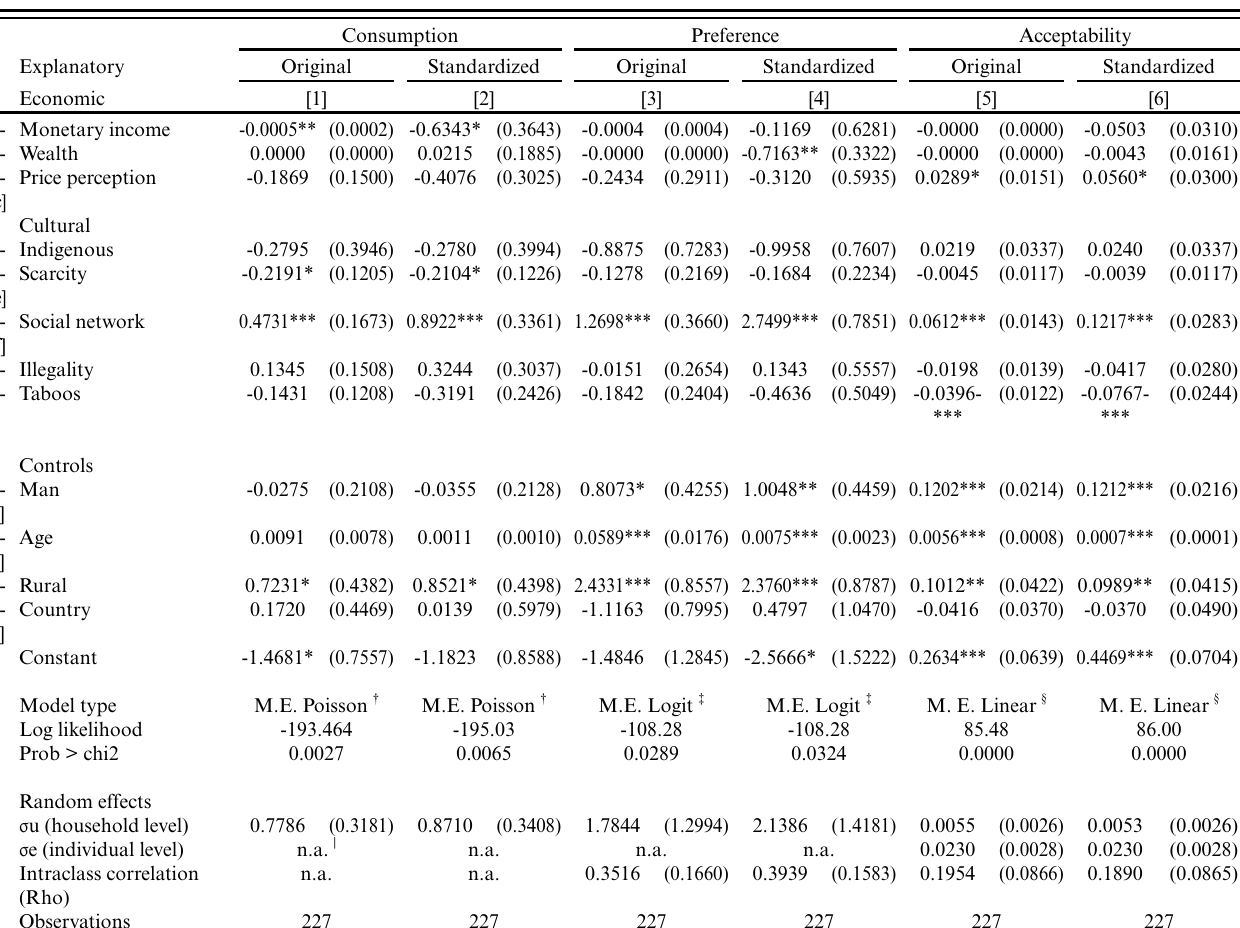
Table 3 . Results of mixed-effects regressions of the association between economic and cultural indicators with bushmeat consumption and